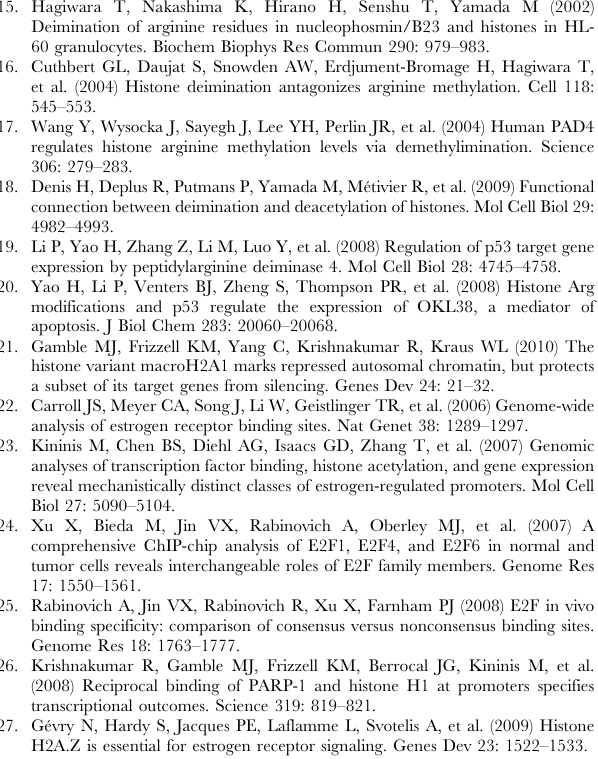
Figure S4 Putative consensus sequence for each transcription factor. The top 21 motifs are listed in order of significance according to Figure 3A. Sequence logo images were created using the position weight matrices from the Transfac database (http:// www.gene-regulation.com/pub/databases.html) and the R pack- age, SeqLogo. Figure S5 Western Blot with anti-Elk-1 antibody showing shRNA-mediated depletion of Elk-1 in HEK293 cells versus shRNA control knockdown cells. b -Actin was used as internal control showing the equal protein loading. Figure S6 Dose-dependent effect of Cl-Amidine on c-Fos expression. Real-time RT-PCR analysis of c-Fos and GAPDH expression in serum-starved or EGF-stimulated MCF-7 cells with or without Cl-Amidine treatment. Figure S7 EGF-induced c-Fos gene expression is inhibited by Cl- Amidine treatment in other breast cancer cells. Real-time RT- PCR analysis of c-Fos expression in serum-starved or EGF- stimulated BT474 and MCF10DCIS breast cancer cells with or without Cl-Amidine treatment. Figure S8 Luciferase reporter assay with construct driven by the c-Fos promoter in HEK293 cells showing that PADI4 enzymatic activity facilitates Elk-1 mediated activation of c-Fos . Either wild type (WT) or C645S mutant (CS) PADI4 with N-terminal Flag tag and either wild type (WT) or dominant negative (DN) Elk-1 with N-terminal HA tag were co-transfected with the c-Fos reporter construct ( c-Fos promoter fragment containing 531 nucleotides which begins 85 nucleotides downstream from the TATAA box